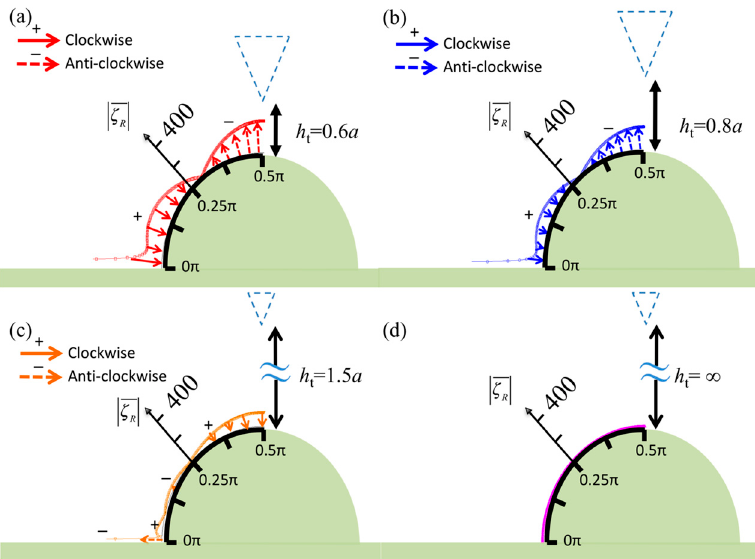
Figure 6. Normalized vorticities in real part over the surface of the semicircular specimen when the diameter of the semicircle d = a and the tip height is ( a ) h t = 0.6 a , ( b ) h t = 0.8 a , ( c ) h t = 1.5 a , and ( d ) h t = ∞ .